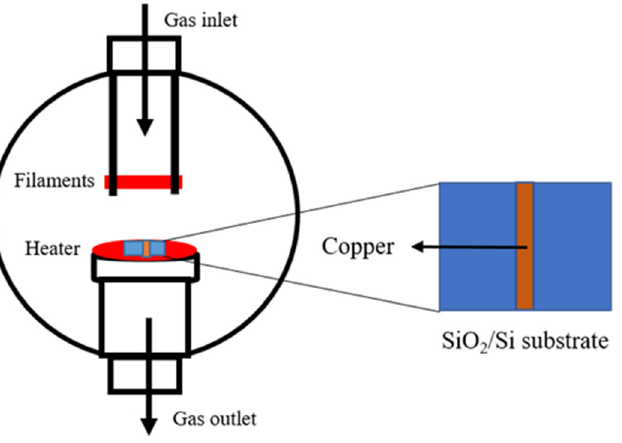
Figure 1. Hot filament chemical vapor deposition (HFCVD) reactor schematic and the SiO 2 /Si substrate with the deposited copper-strip.